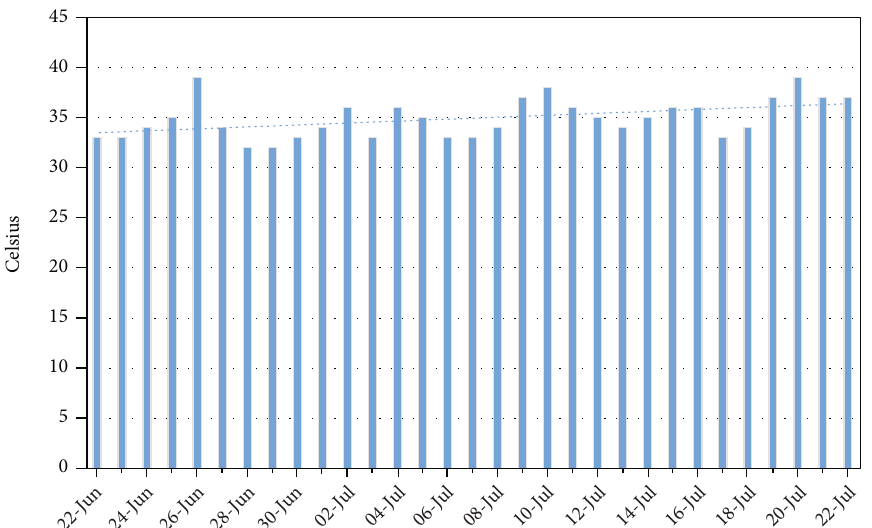
Figure 7: Temperature in Tehran from June 22 to July 22.